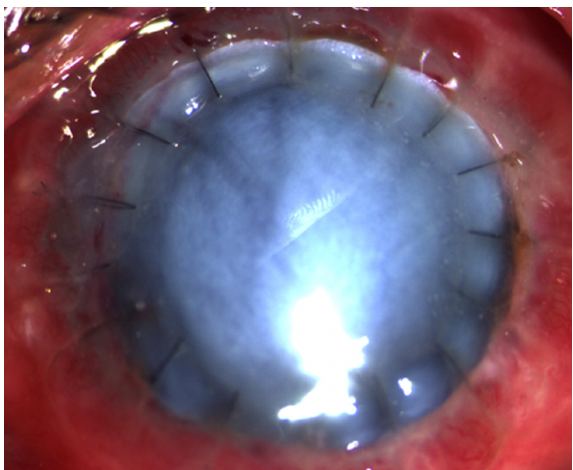
Figure 3: Slit lamp photograph of eye at the first day postoperatively showing a tectonic graft held in place with #16 interrupted nylon 10-0